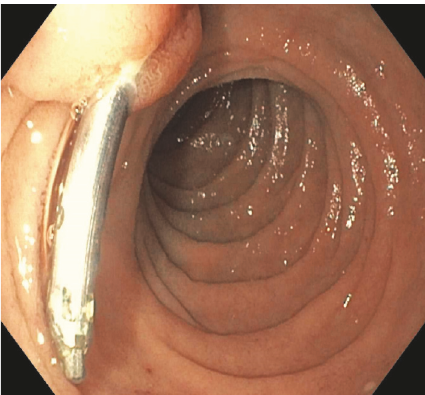
Figure 1: Hemostatic clip on the ampulla of Vater.